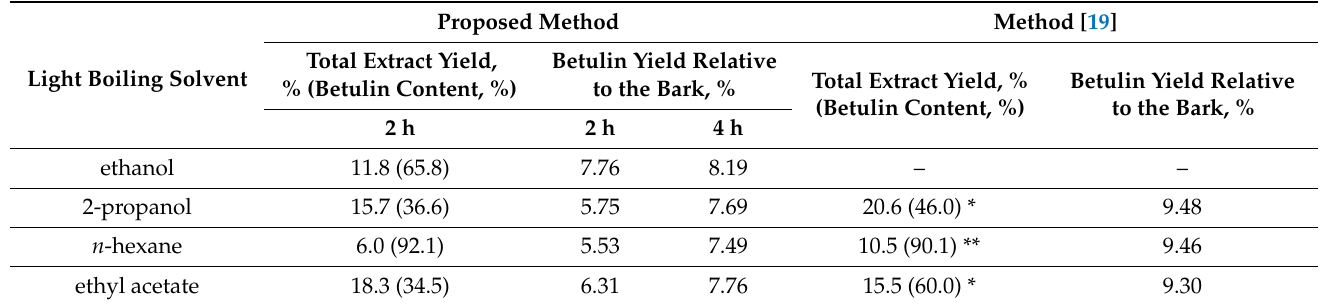
Table 3. Dependence of extraction product yields on the time and nature of the